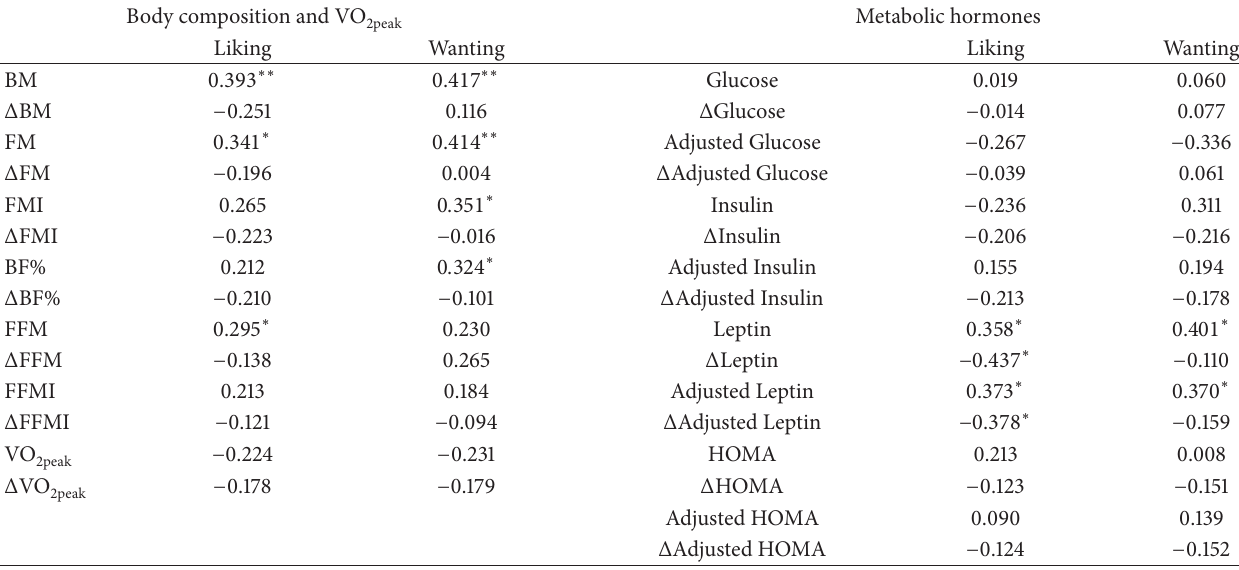
Table 3: Pearson partial correlation coefficients (controlling for sex) between food reward and the cross-sectional and exercise-induced changes in body composition and fasting metabolic-related